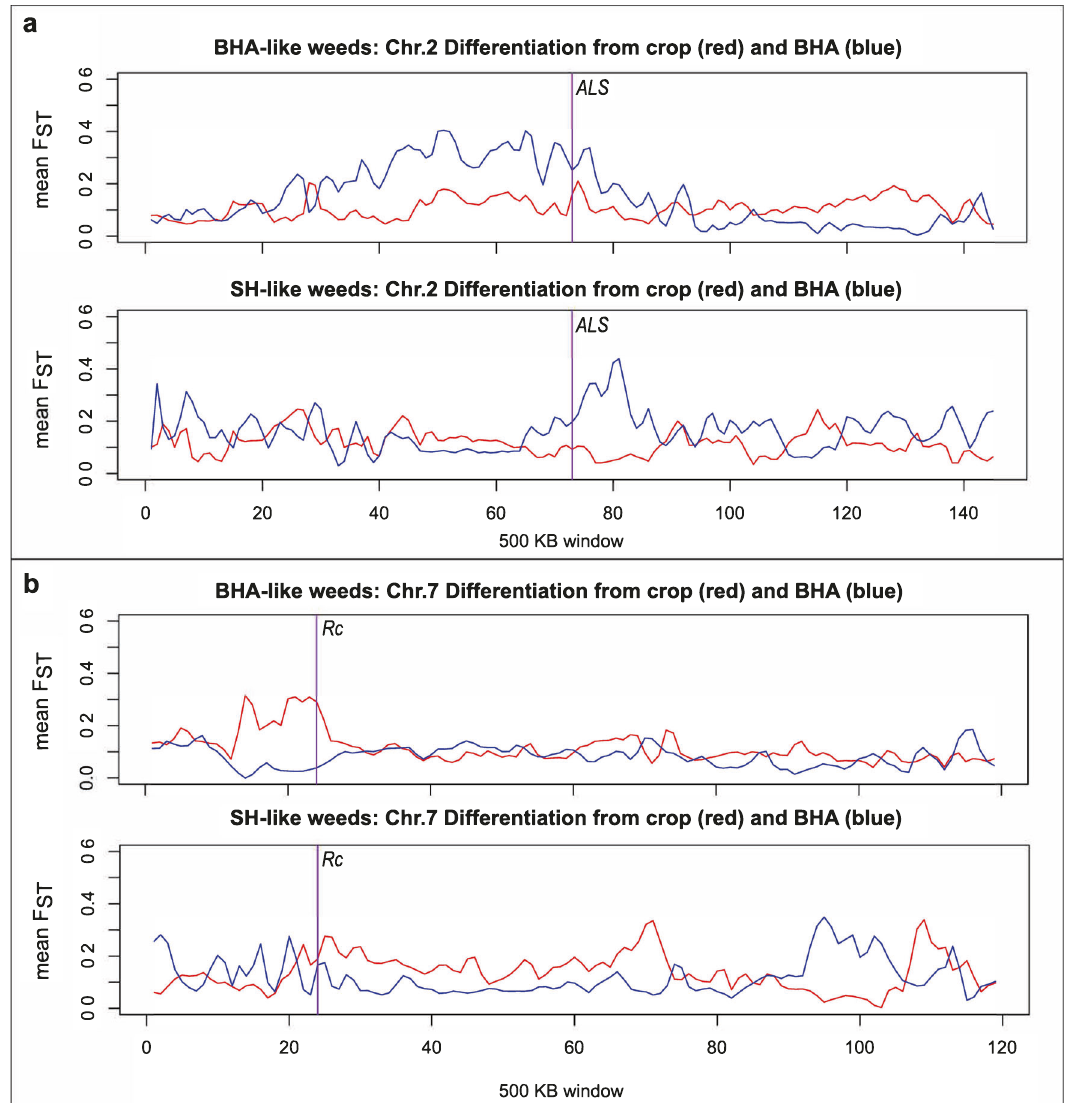
Fig. 3 F ST analysis across two chromosomes containing genes important for weedy rice survival. F ST between contemporary weeds and their presumed ancestors in two chromosomes (chr. 2, a and chr. 7, b ) containing genes associated with contemporary weed adaptation ( ALS , herbicide resistance; Rc , seed dormancy). Red lines represent the F ST between cultivated and contemporary weedy populations; blue lines represent F ST between historical and contemporary weedy populations. The vertical purple lines denote the 500-kb window containing the focal